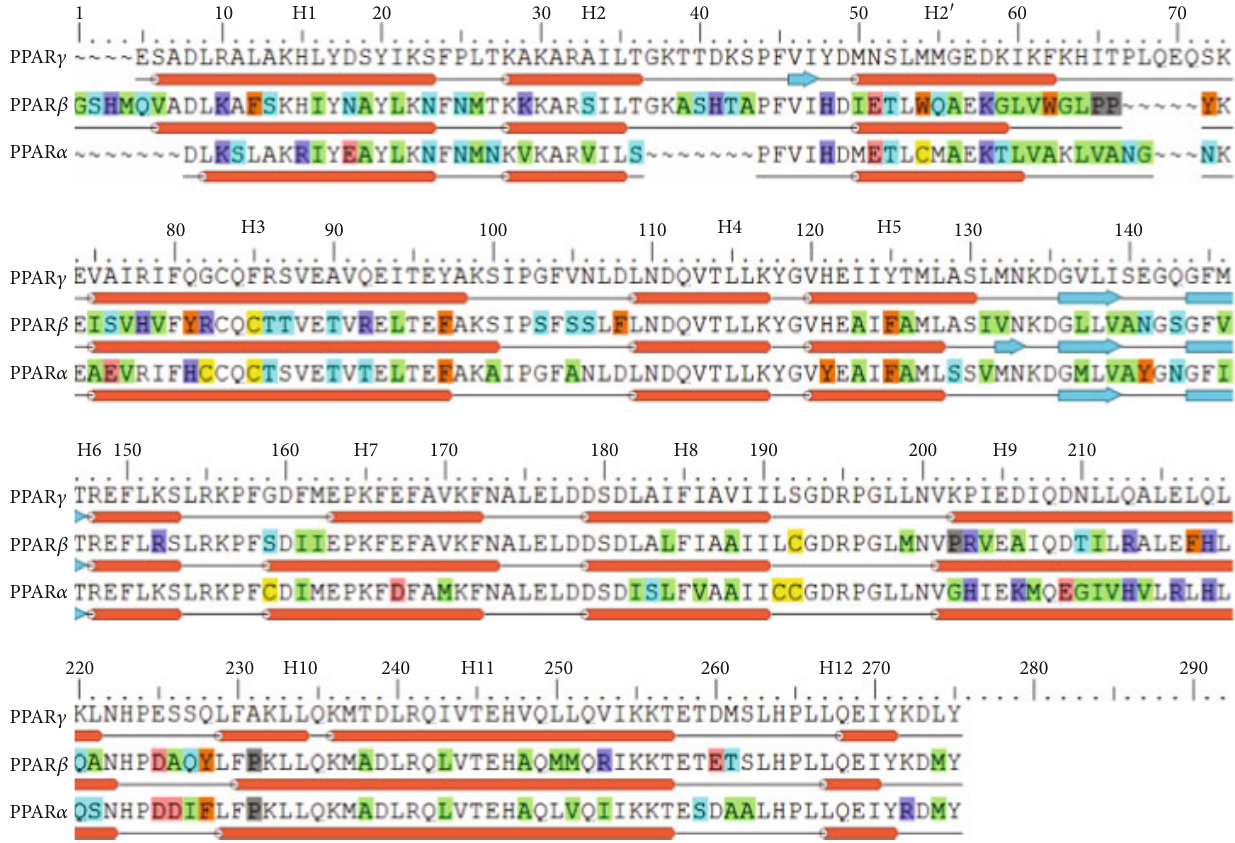
Figure 1: Sequence alignment of PPAR α (PDB ID: 3VI8), PPAR β (PDB ID: 3TKM), and PPAR γ (PDB ID: 2PRG): 202 (alpha), 174 (beta/delta), and 238 (gamma). The sequences were aligned using PPAR γ as a reference, and each residue that di ff ers is colored based on side-chain chemistry. See Materials and Methods for reference to colors.